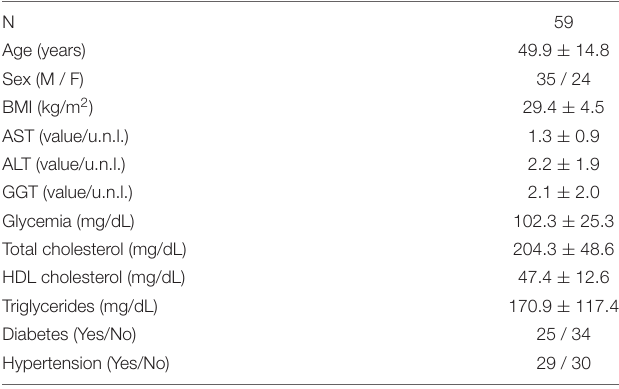
TABLE 3 | Biological, anthropometric, and biochemical characteristics of the NAFLD